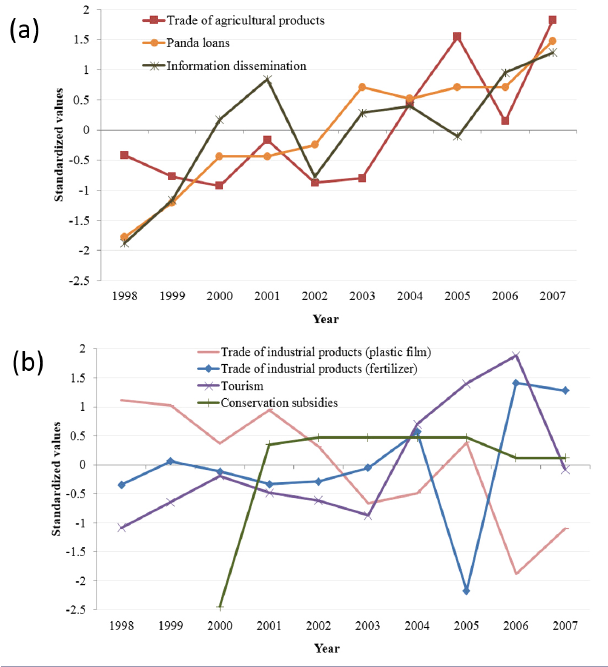
Fig. 8 . Changes in telecouplings for those with flows (a) leaving and (b) entering Wolong Nature Reserve from 1998 to 2007. Values shown are standardized across years. Trade in agricultural products refers to total income from cash crops and livestock in Wolong. Panda loans are the number of pandas sent out from Wolong to outside zoos, on loan. Information dissemination refers to the number of international news articles containing the words “Wolong Nature Reserve” and published in the English language. Trade of industrial products is presented in two parts: total amount of fertilizers and total plastic film purchased by Wolong residents. Tourism refers to the total number of incoming tourists